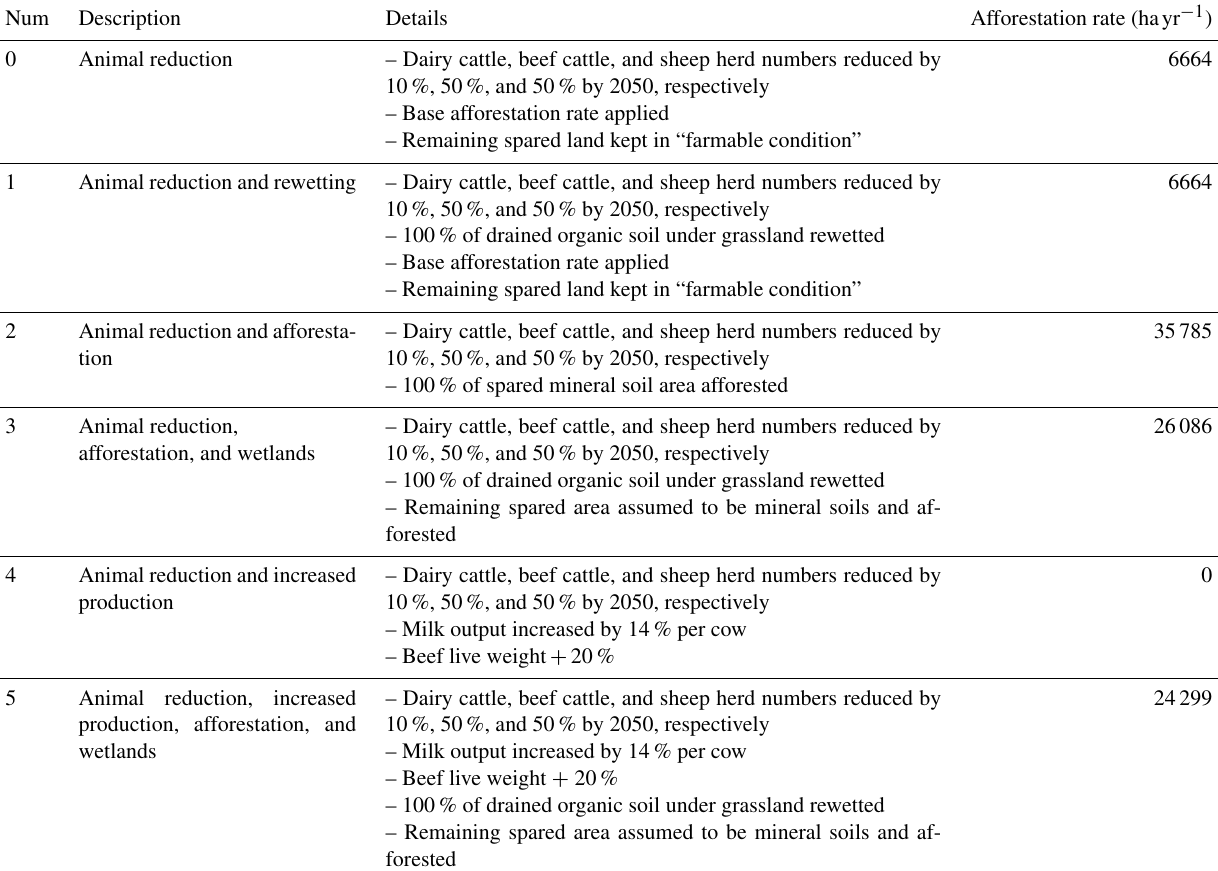
Table 5. Summary of indicative scenarios analysed using